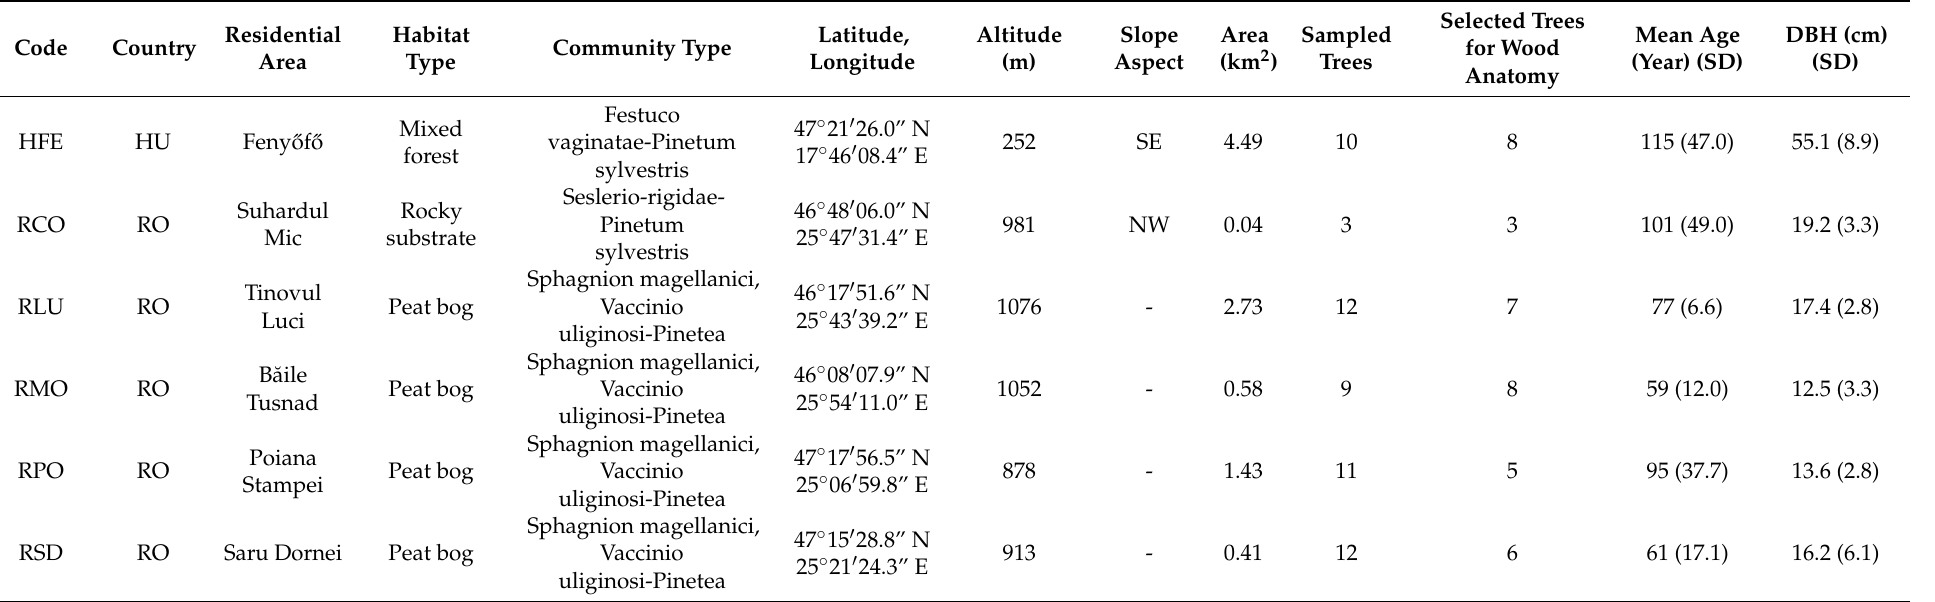
Table 1. Main features of the studied peripheral Pinus sylvestris L. populations from the Carpathian Basin and the Eastern Carpathians.